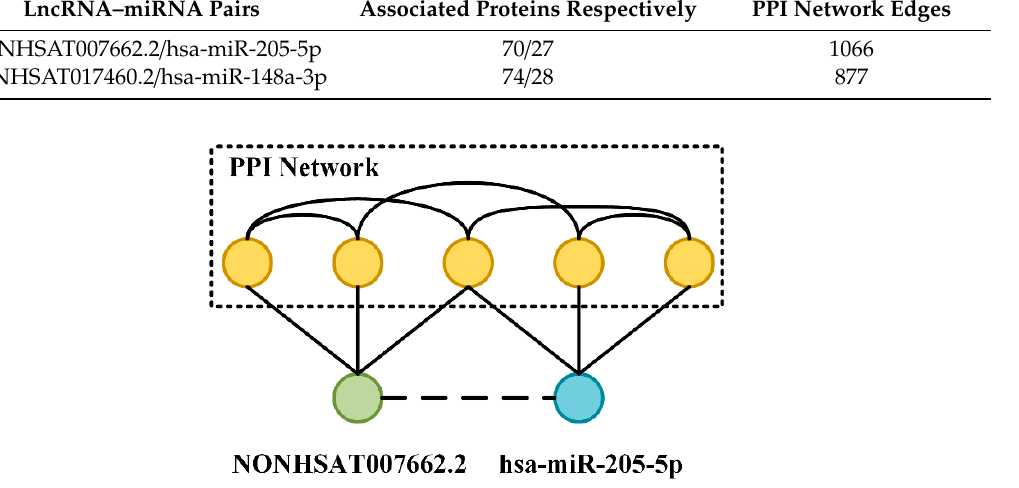
Figure 8. NONHSAT007662.2 / hsa-miR-205-5p interaction and their PPI network.